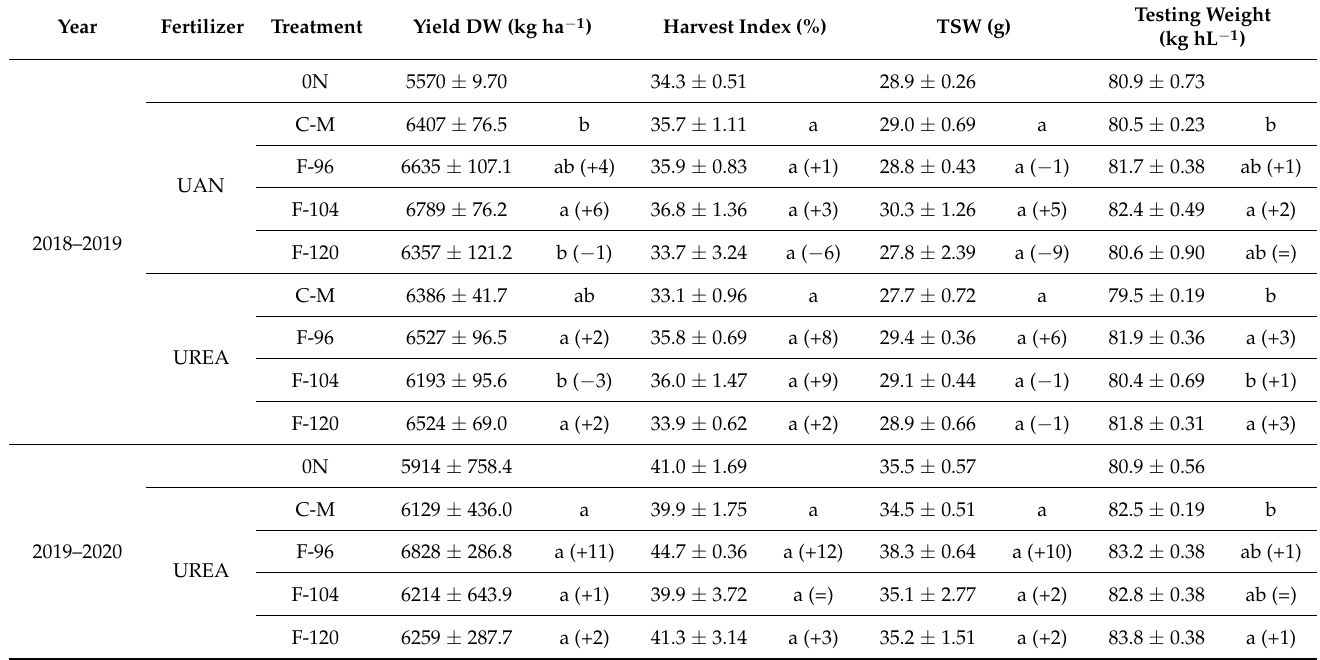
Table 3. Productivity parameters: grain yield, harvest index (HI), thousand seed weight (TSW) and testing weight (mean ± S.E.; n = 3) in wheat plants under different foliar N fertilization treatments in a two-year field trial with UAN and urea as fertilizers. In brackets: % variation vs. each conventional management C-M. Letters: statistical comparisons among treatments within same fertilizer (Newman–Keuls test, p ≤